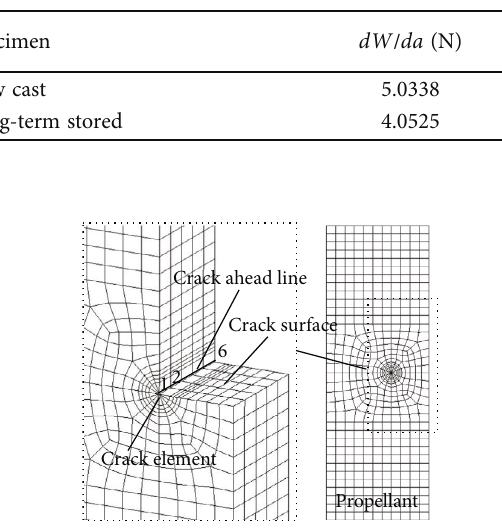
Figure 10: The unilateral crack specimen model and 3D crack element meshing (normal temperature).